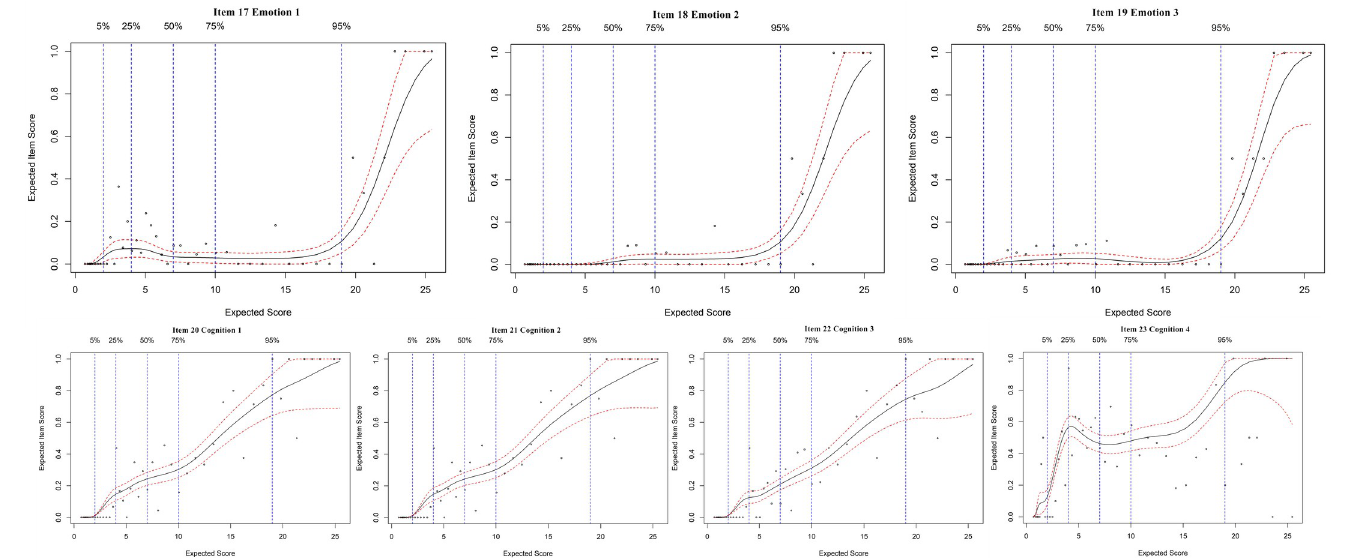
Fig 3. Expected item score curves for psychological